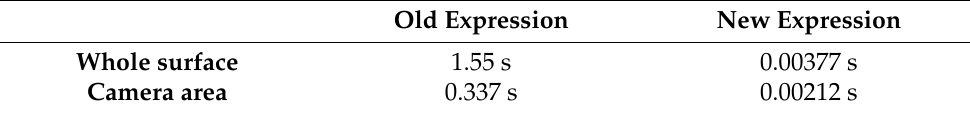
Table A1. Computation time with both expressions with two different observation functions.